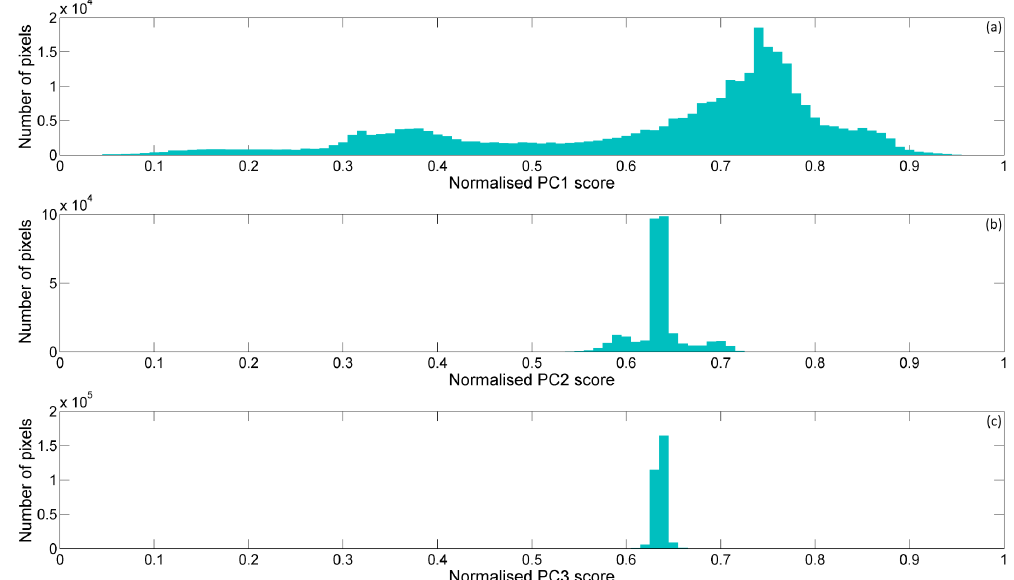
Figure 5. Frequency histograms of the normalized PC score matrix with decreasing explained variance from column 1 to 3 ( PC sc ,n 1 to PC sc ,n 3): while the information stored in PC sc ,n 1 (a) is largely redundant with the information given and analysed by the blue band of the RGB space, the PCA facilitates the separation of shaded snow cover from other surfaces by comparing PC sc ,n 2 (b) to PC sc ,n 3 (c) values using Eq. (3).